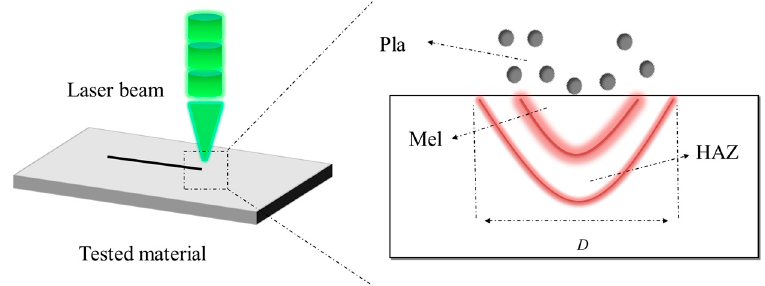
Figure 1. Schematic diagram of nanosecond laser processing.